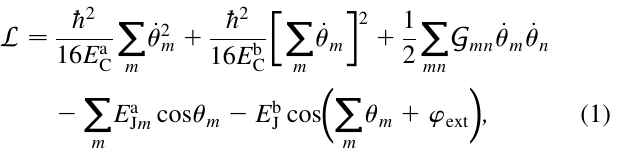
, shunting one weaker junction C and E b , J C